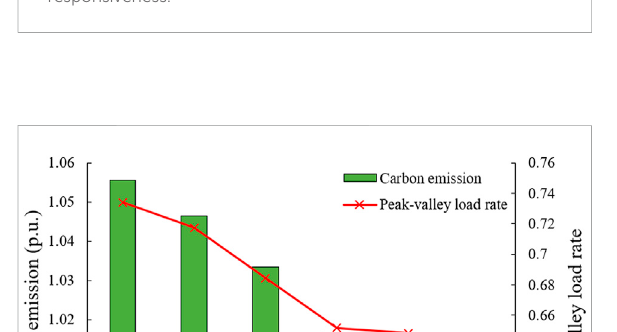
FIGURE 10 Comparison of operating costs for EVs with different responsiveness.